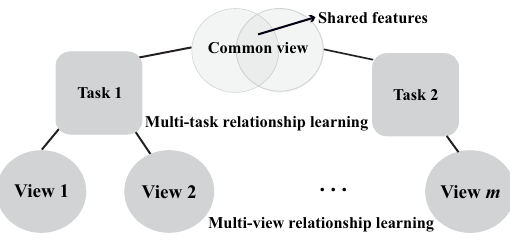
Fig. 13 Co-clustering based M 2 vC framework [174]